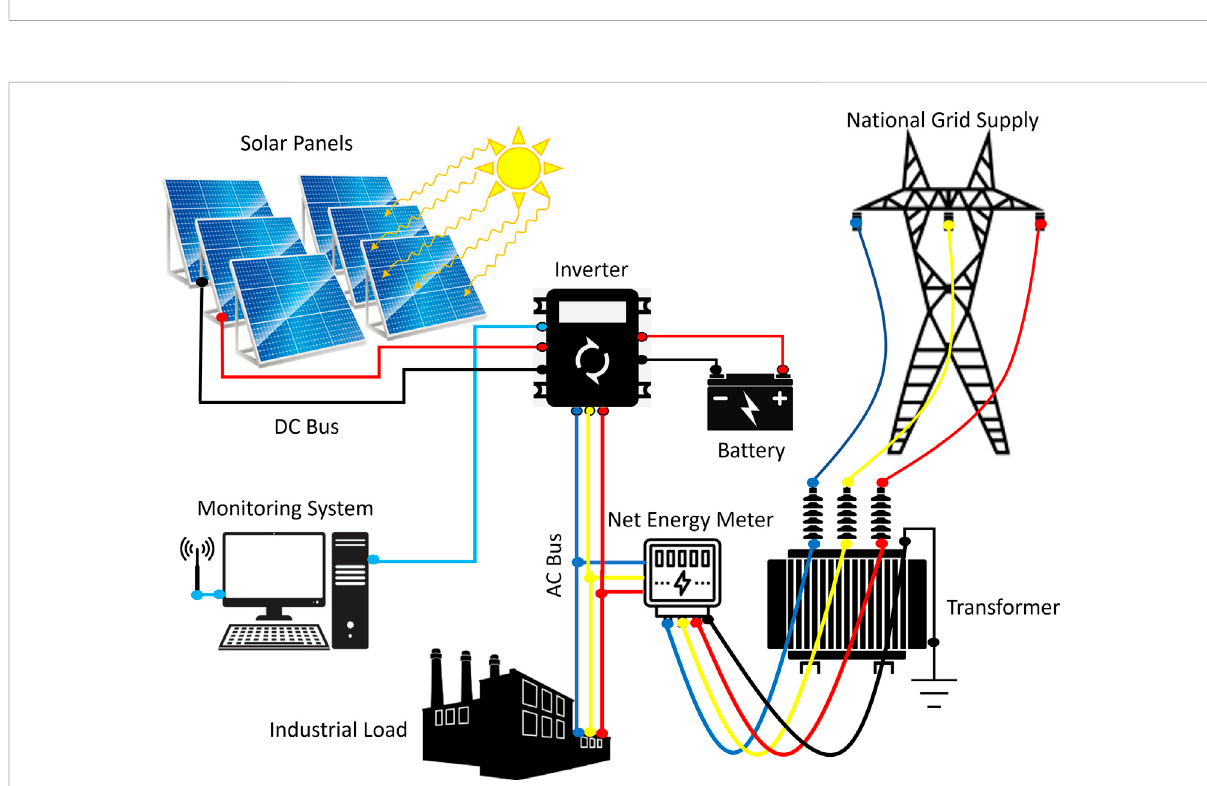
FIGURE 10 Schematic diagram of a grid-connected solar PV system.